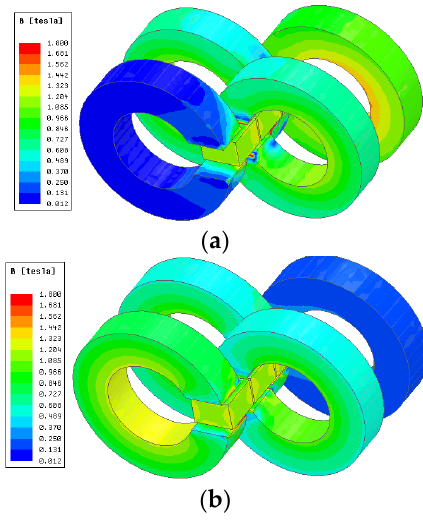
Figure 7. The distribution of magnetic flux density at a stroke of 11 mm and with a sinusoidal RMS 1.2 A current supply ( a ) at displacement of 5.5 mm ( b ) at displacement of 0 mm.